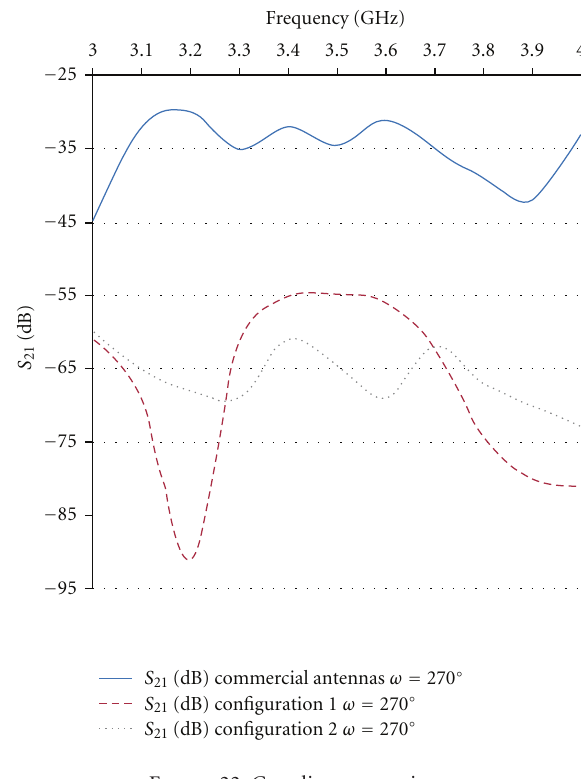
Figure 22: Coupling